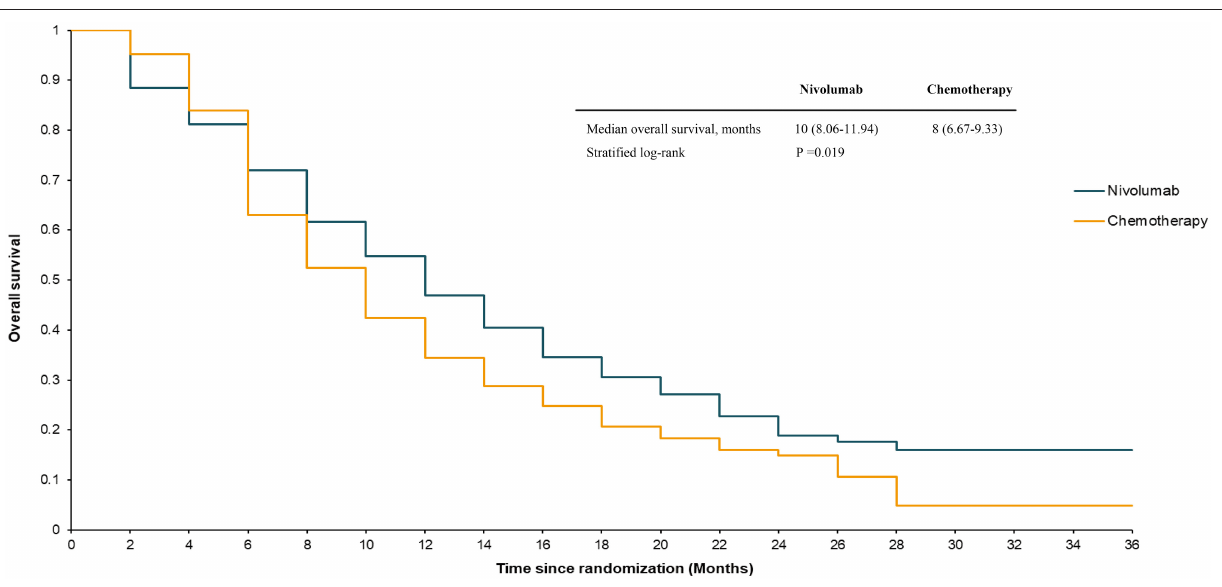
FIGURE 2 | Estimated overall survival curve for the ATTRACTION-3